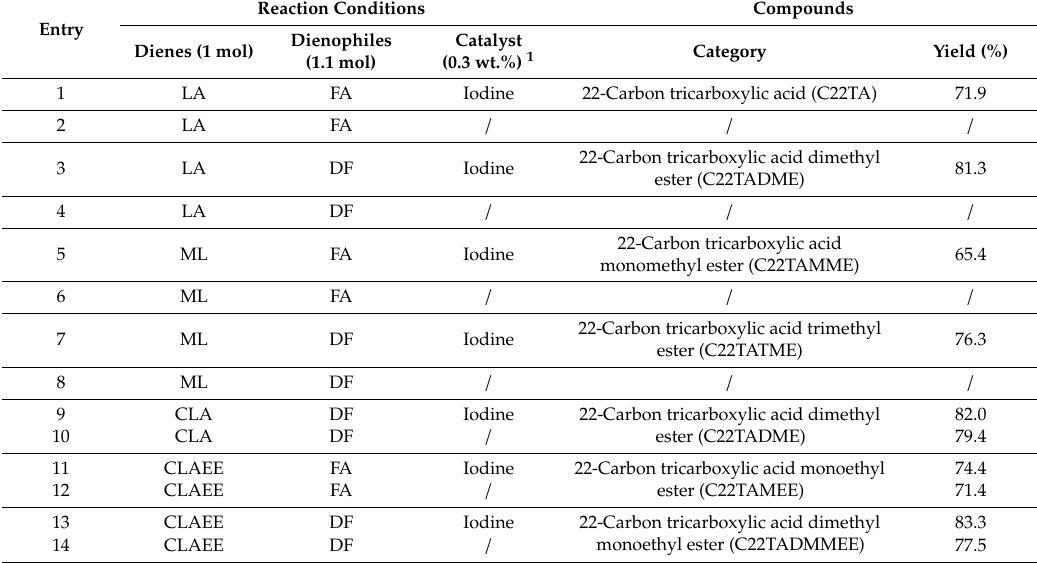
Table 1. Preparation and yield of 22-carbon tricarboxylic acid (C22TA) and its ester (C22TAE) via Diels–Alder reaction. FA—fumaric acid; DF—dimethyl fumarate; LA—linoleic acid; ML—methyl